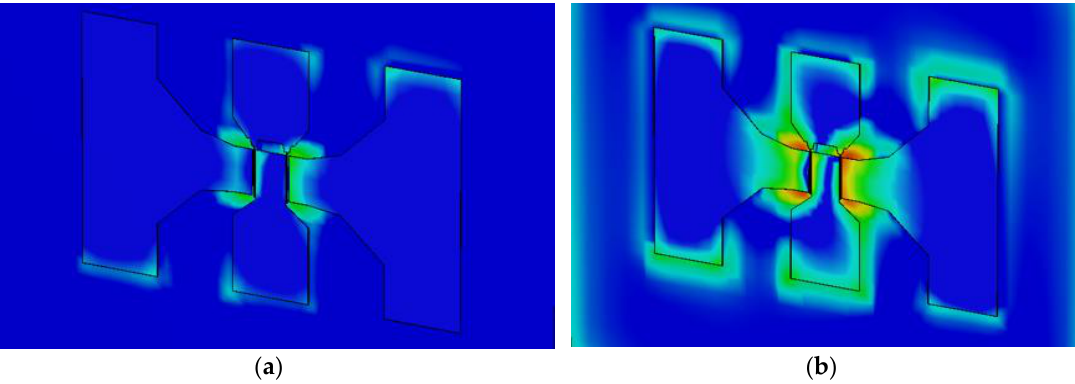
Figure 6. Spatial distribution of the module of the normalized induced electric field under front, ( a ), and back, ( b ), illumination at 0.3 THz at the plane of the transistor channel (it is found in simulations that the induced electric field is mainly developed in the channel of the FET). The maximum values of the normalized electric field in the plotted plane are 18.47 dB and 29.58 dB for front and back illumination, respectively. Black solid lines indicate the contour of the top side transistor electrodes and are a guide to the eye.